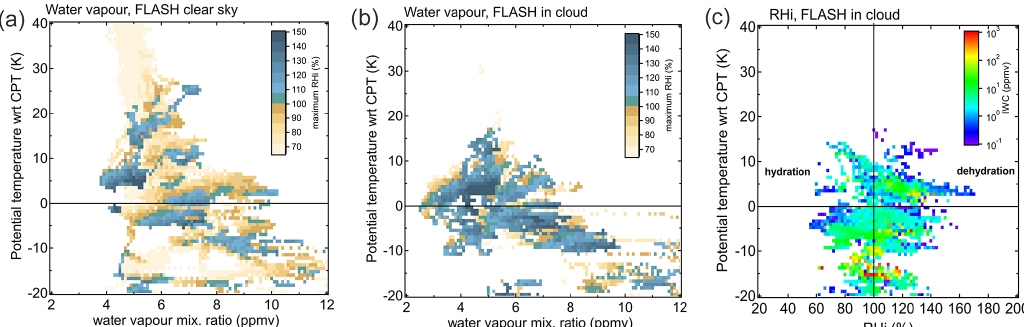
Figure 3. (a, b) Binned distribution of maximum RHi (computed from FLASH and TDC measurements) as a function of FLASH water vapour and potential temperature relative to the local CPT level (bin size 0.1ppmv by 1K) for (a) clear-sky conditions and (b) cloud occurrence detected by MAS (see Sect. 2.1.2). (c) Binned distribution of ice water content (IWC) exceeding 0.1ppmv from NIXE-CAPS instrument inside clouds detected by MAS as a function of relative humidity over ice (RHi) and potential temperature relative to the local CPT level. The presence of ice crystals in subsaturated air (RHi < 100%) above the cold point tropopause potentially leads to permanent hydration of the CLS, whereas in supersaturated air the ice crystals are expected to sediment out of the CLS, thereby leading to its